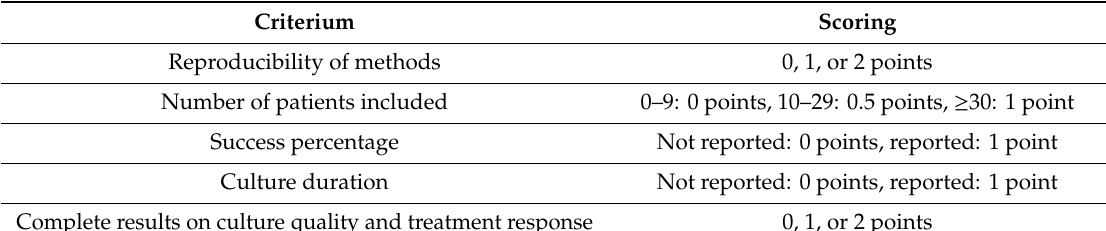
Table 1. Criteria and scoring for the selection of key publications .